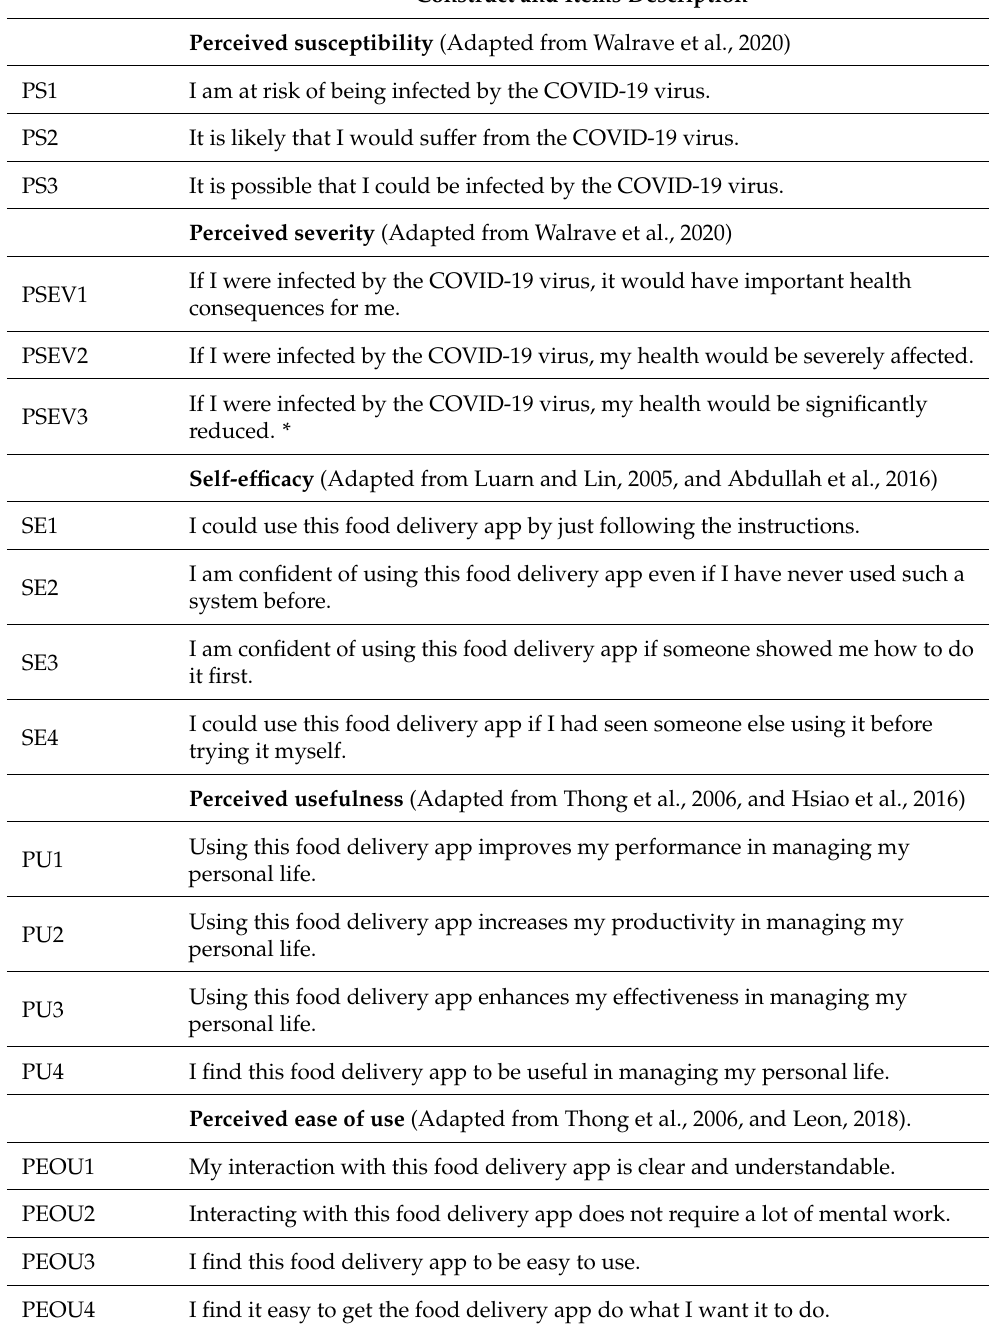
Construct and Items